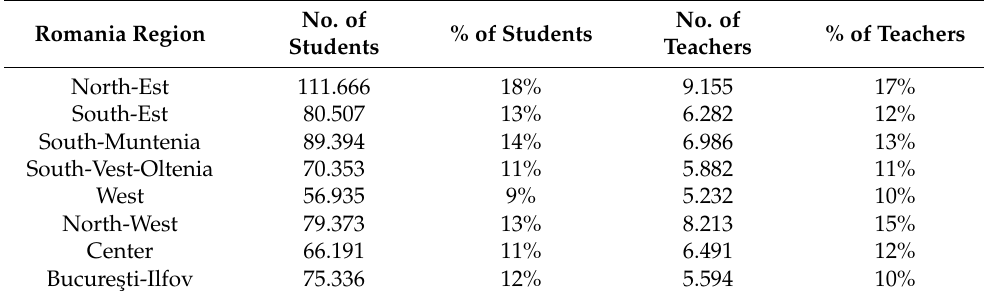
Table 1. The number of enrolled students and teachers in high school by development regions, at the beginning of the 2018–2019 school